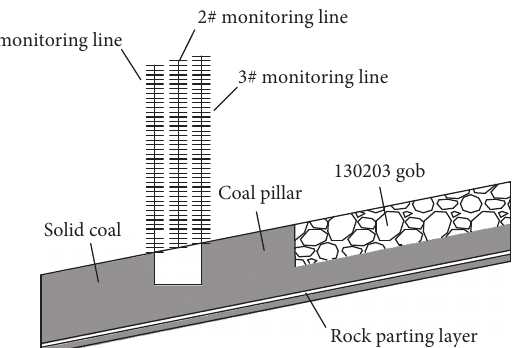
Figure 7: Monitoring point arrangement plan in the roof of the